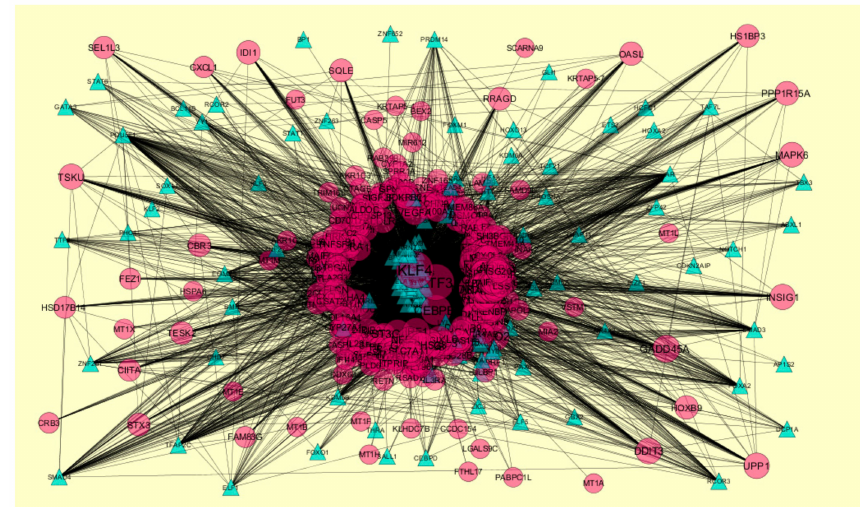
Figure 16. The network of down-regulated di ff erential expressed genes (DEGs) and their related transcription factors (TFs). (Blue triangles—TFs, and pink circles—target down-regulated